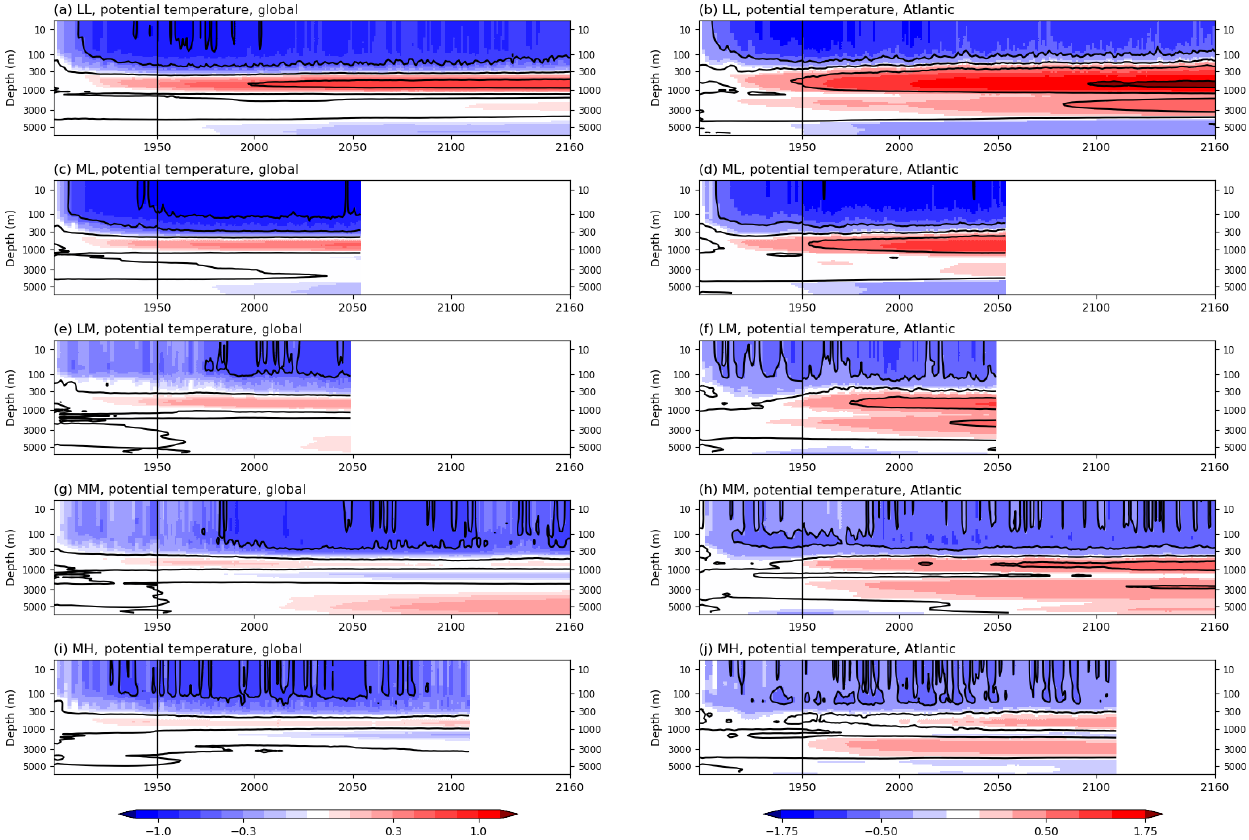
Figure 10. The mean ocean potential temperature anomaly (compared to year 1) on model levels against time for the (left) global and (right) Atlantic Ocean basins, from the spinup-1950 period to the first 210 years (where available) of control-1950. Note the different scales for the different